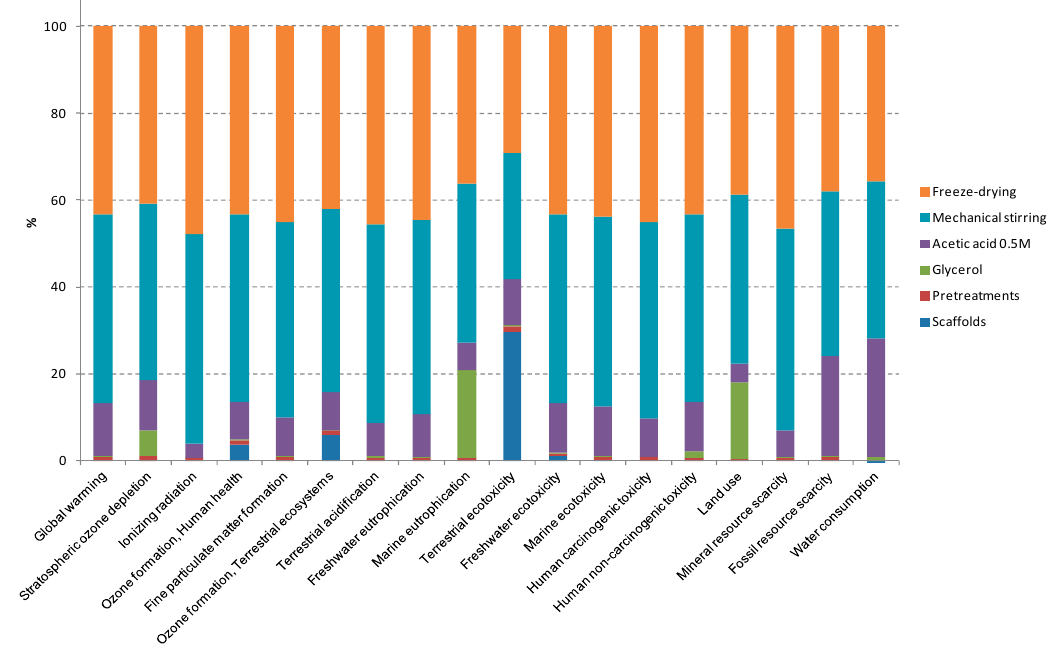
Figure 1. Relative contributions in each impact category for the most relevant processes involved in the entire life cycle of collagen scaffolds. Disaggregating environmental results are displayed in percentage ratios for the most relevant contributing factors: pretreatments, mechanical stirring, acetic acid solution (0.5 M), glycerol, and freeze ‐ drying.